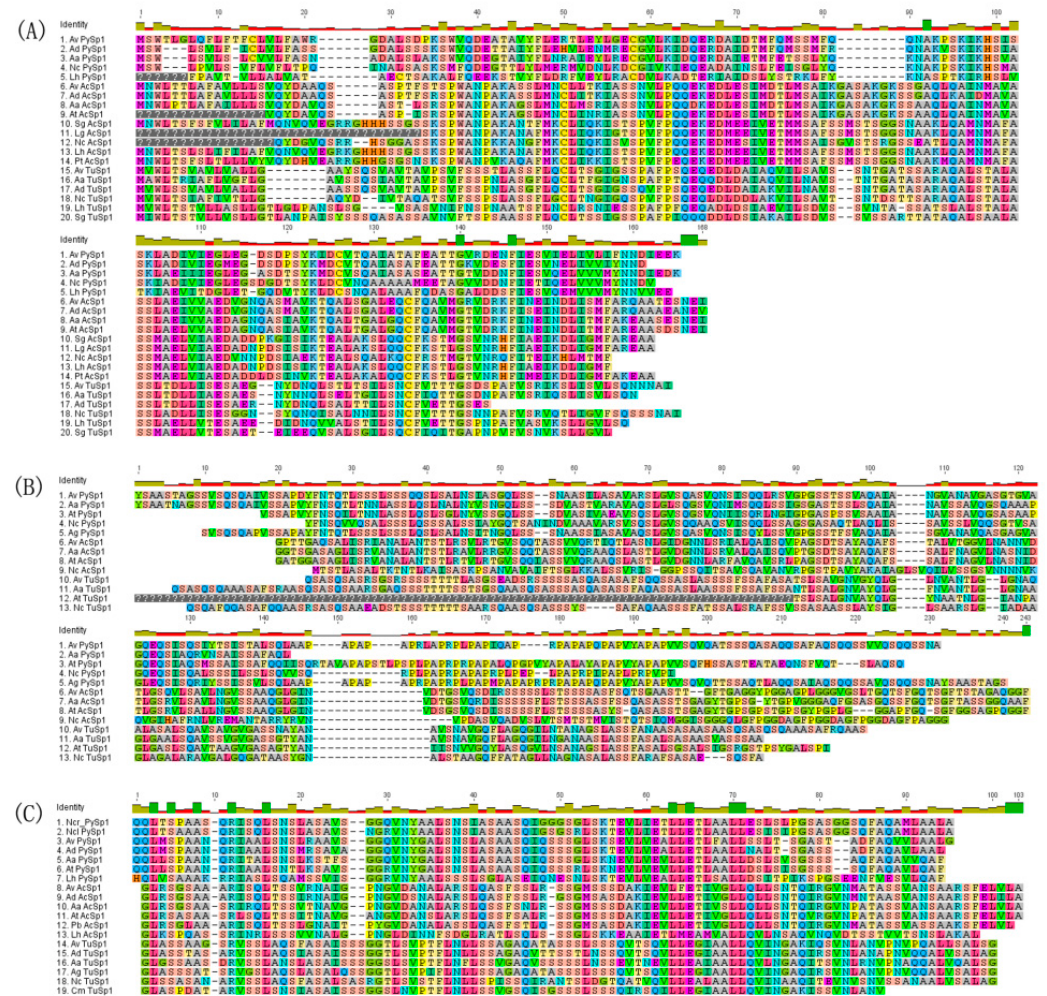
Figure 5. Alignment of the repeat units, N- and C-terminal domains amino acid sequences of three types of spidroins (PySp1, AcSp1, and TuSp1). ( A and C ) Alignment of N-terminal domain amino acid sequences ( A ) and C-terminal domain amino acid sequences ( C ). ( B ) Alignment of repeat units’ amino acid sequences. Gaps are represented by dashes. Missing data coded as “?”. The amino acid residues are represented by different colors. Species abbreviations and accession numbers in Supplementary Table S1.